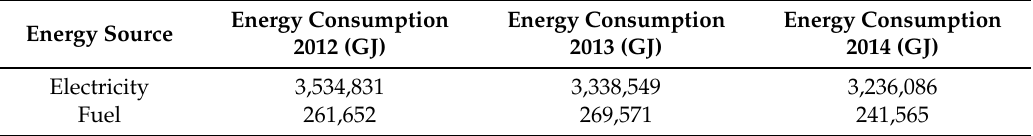
Table 2. Energy consumption in Spanish airports. Source: [9].